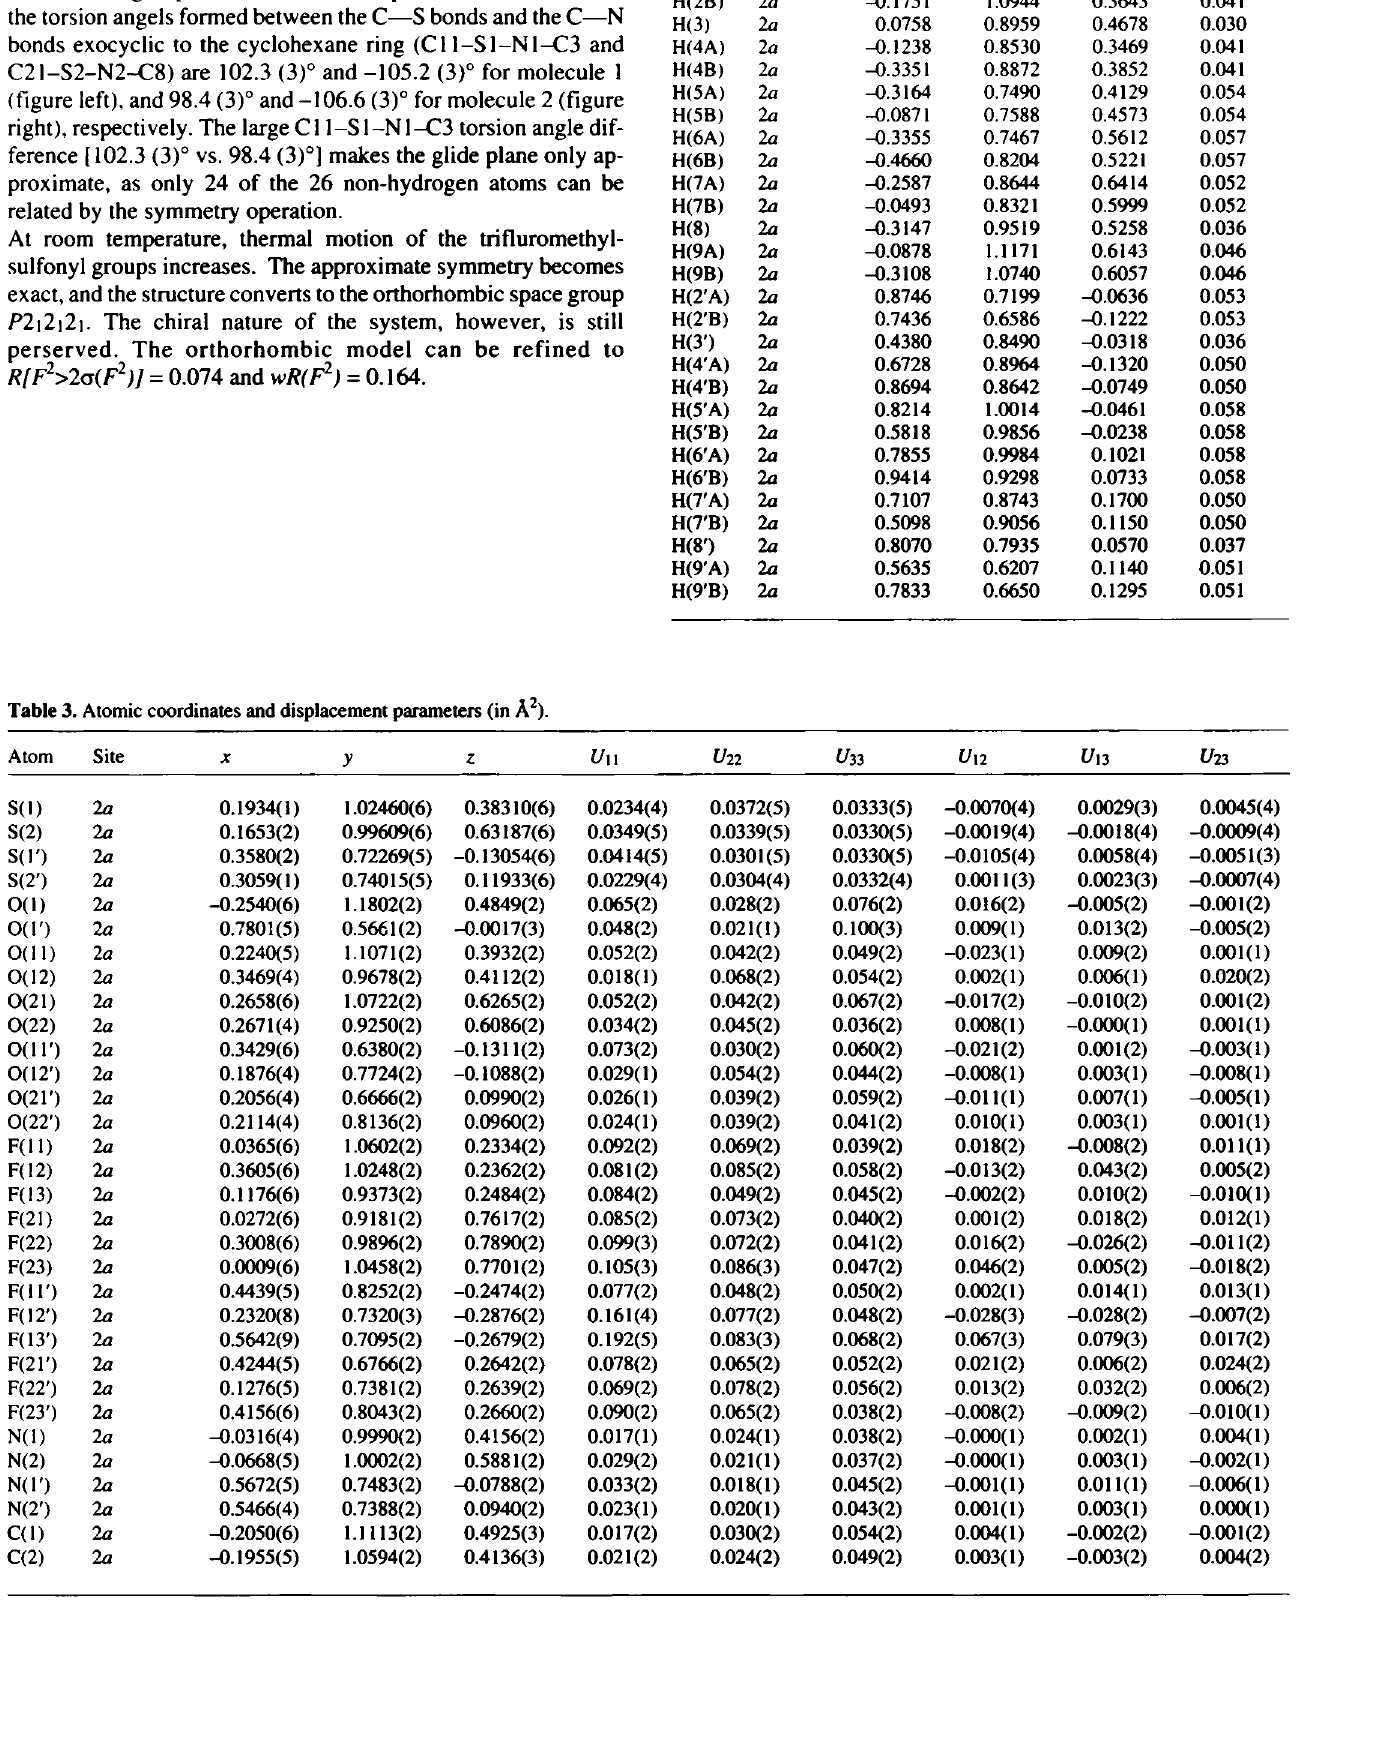
Table 3. Atomic coordinates and displacement parameters (in A 2